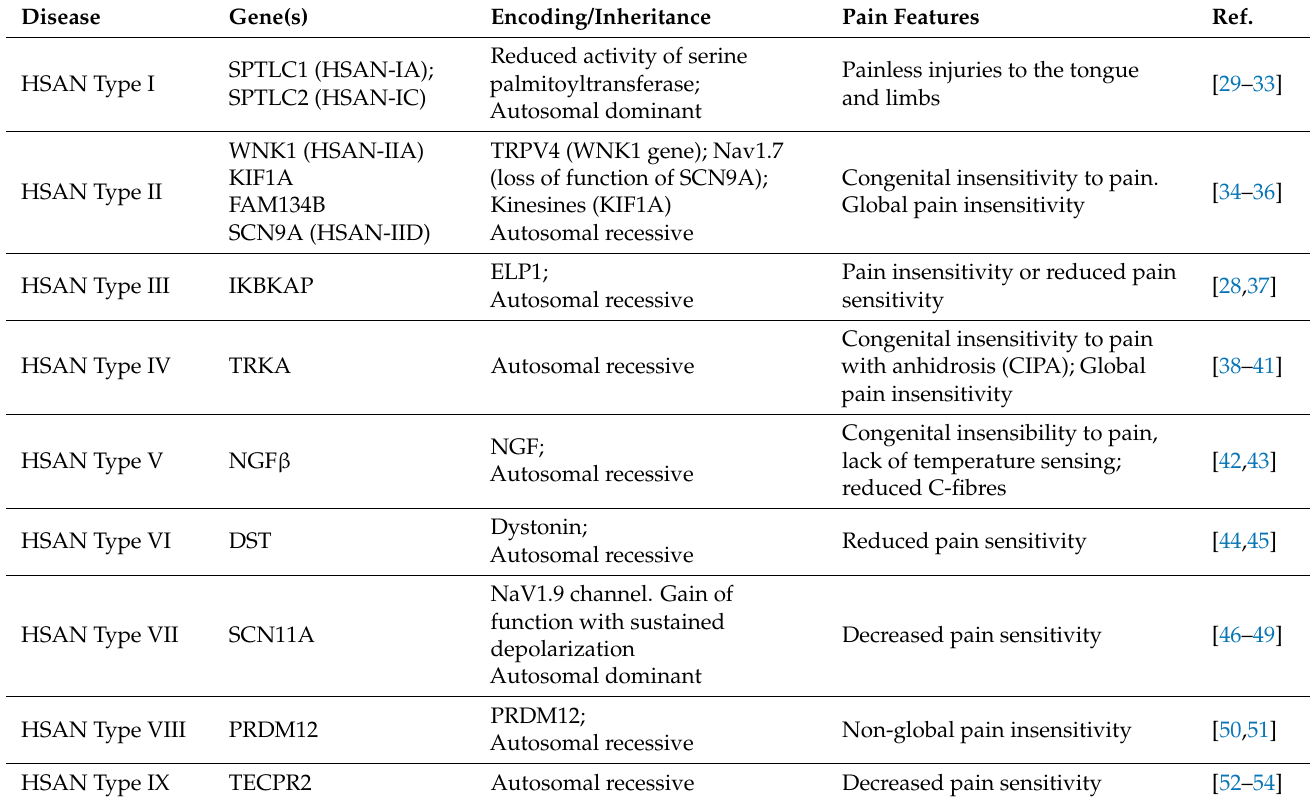
Table 2. Monogenic disorders featuring pain